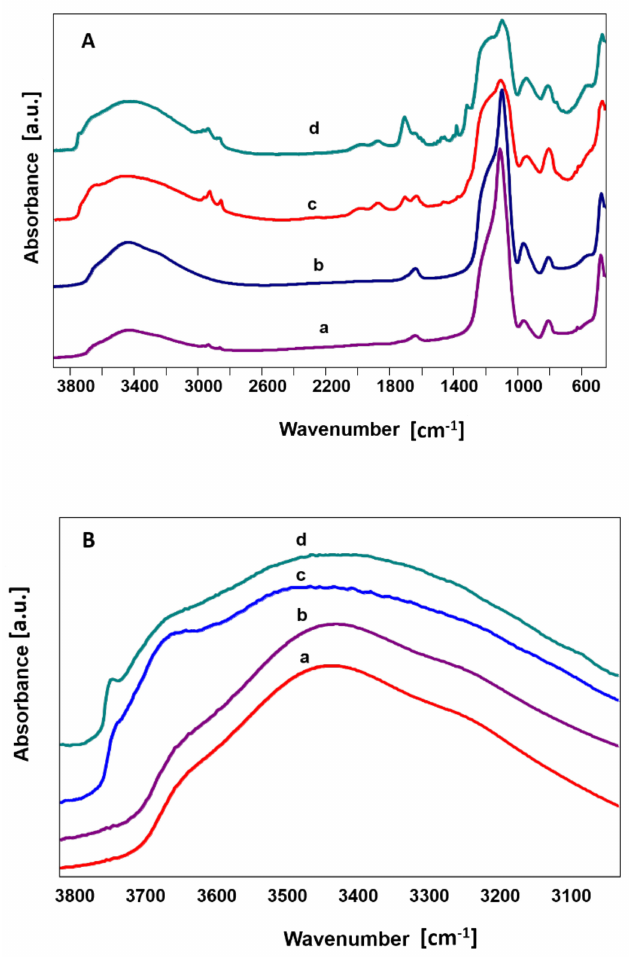
Figure 3. FTIR spectra of silica nanoparticles: lss-SiO 2 (a,c) and hss-SiO 2 (b,d) in all spectrum 580–3800 cm − 1 ( A ). FTIR spectra in transmission mode (a,b) and in DRIFTs mode (c,d) in the range 3000–3800 cm − 1 ( B